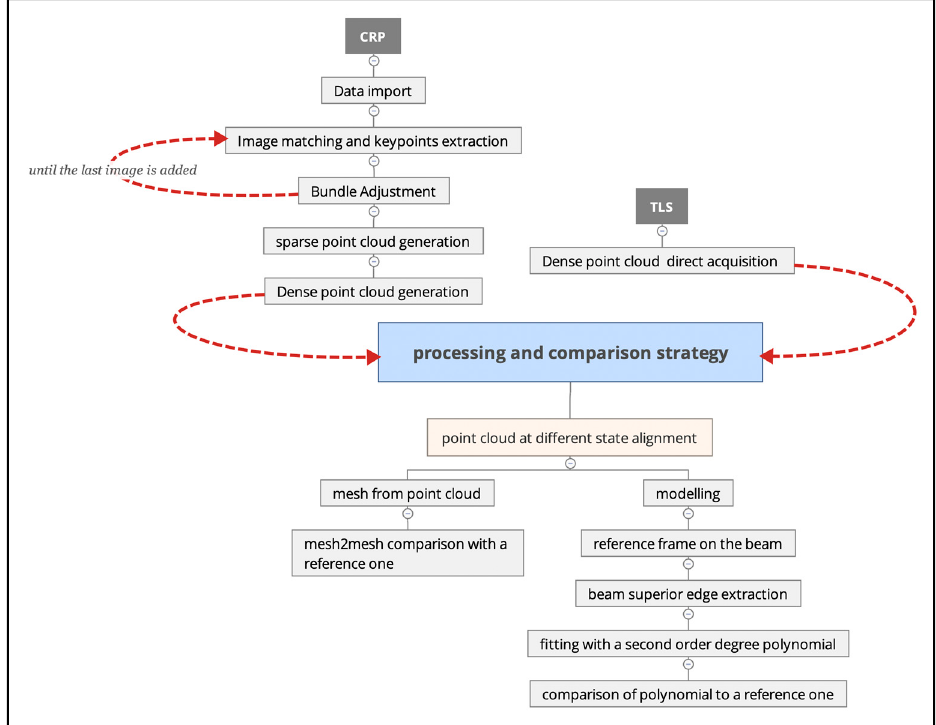
Figure 8. Processing strategy for Close-Range Photogrammetry (CRP) and Terrestrial Laser Scanners (TLS).